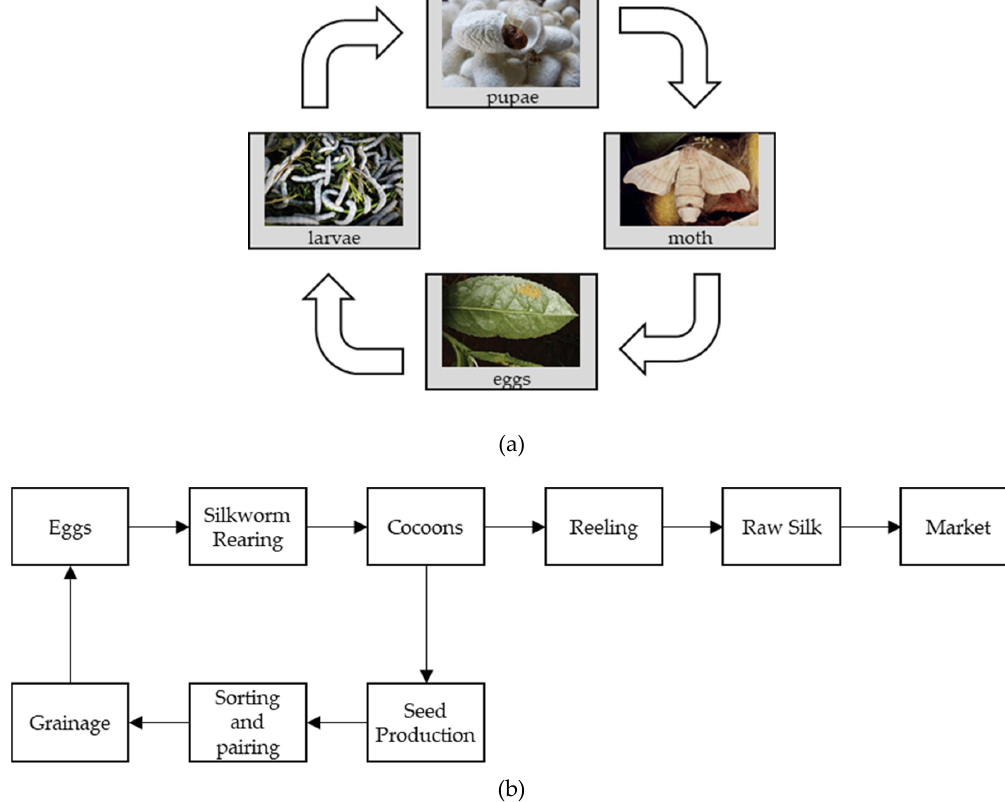
Figure 1. ( a ) Silkworm life cycle, ( b ) silkworm process flow for commercial usage.